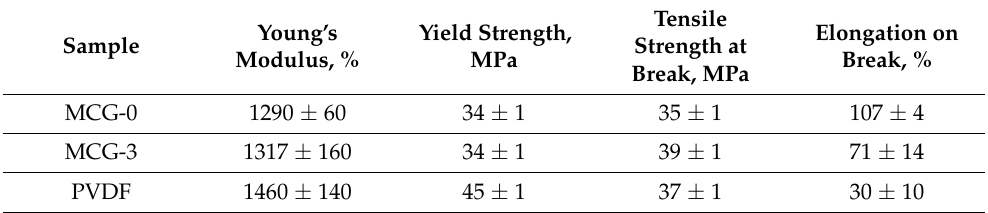
Figure 5. Stress–strain curves of the obtained membranes and the initial PVDF film. One of three curves for each sample type is given. The breakpoint is marked with a star sign. Table 4. Values of Young’s modulus, yield strength, tensile strength, and elongation on break for the studied